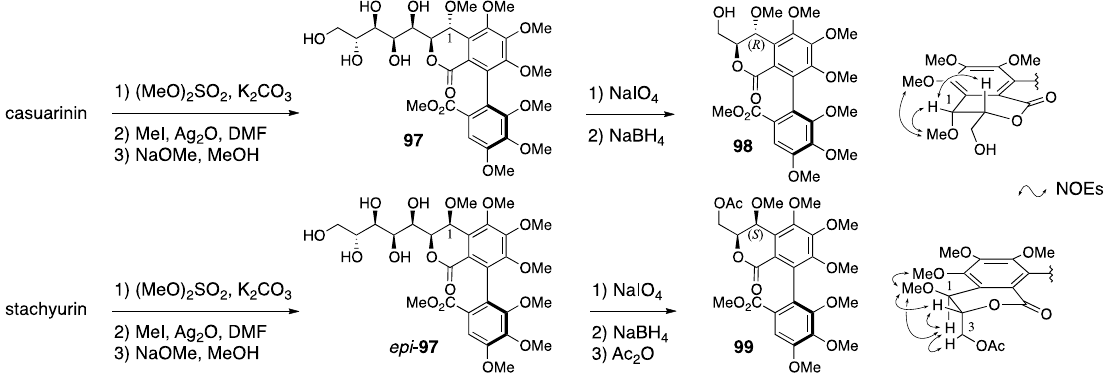
Figure 37. The grounds for swapping the stereochemistry of C-1 to lead to the latest structures of casuarinin and stachyurin. NOE, nuclear Overhauser effect.